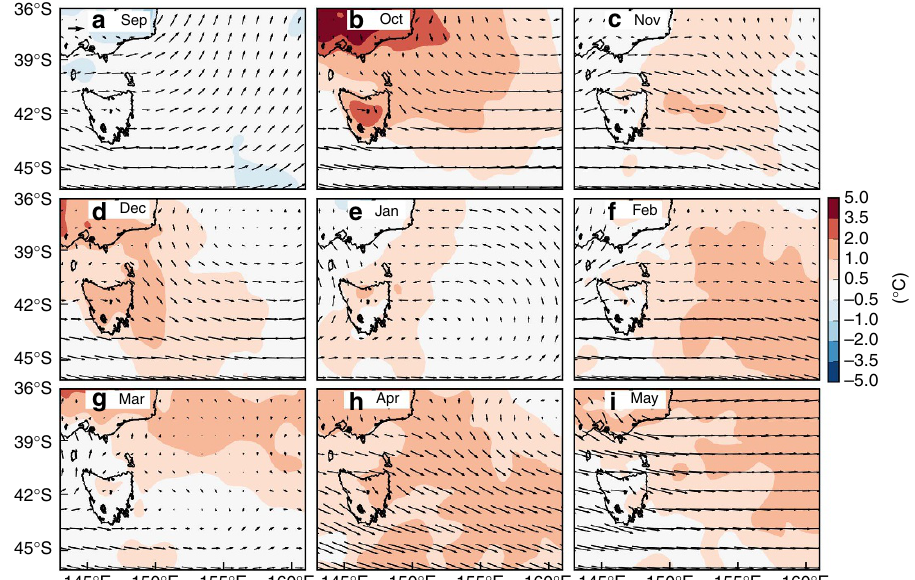
Figure 5 | Monthly mean surface air temperature anomalies and surface winds off southeastern Australia from September 2015 to May 2016. Atmospheric data is from NCEP CFSv2. Air temperatures and winds are shown monthly for ( a-i ) Sep 2015 through May 2016. Colours indicate air temperature anomalies and arrows indicate surface winds. Anomalies are relative to the 2012–2016 period. A reference arrow of 5ms (cid:3) 1 shown in upper left of a .